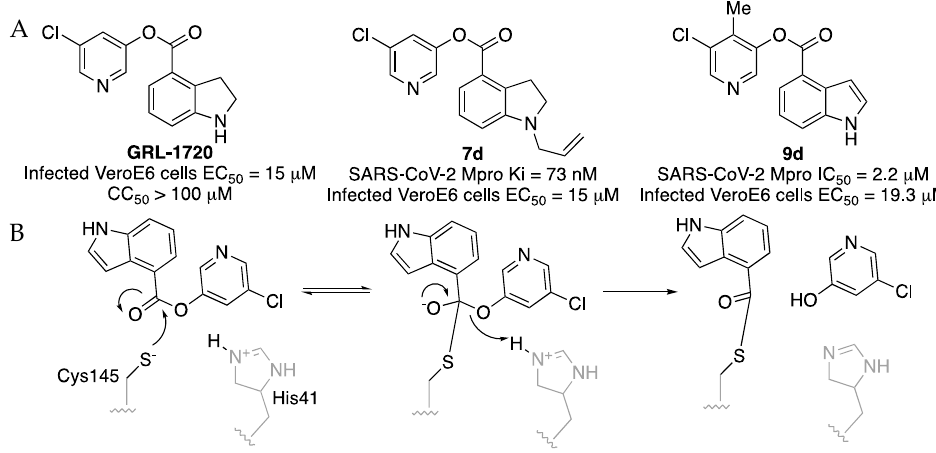
Figure 13. ( A ) Indole chloropyridinyl esters as SARS ‐ CoV ‐ 2 Mpro inhibitors. ( B ) Mechanism of inhibition.